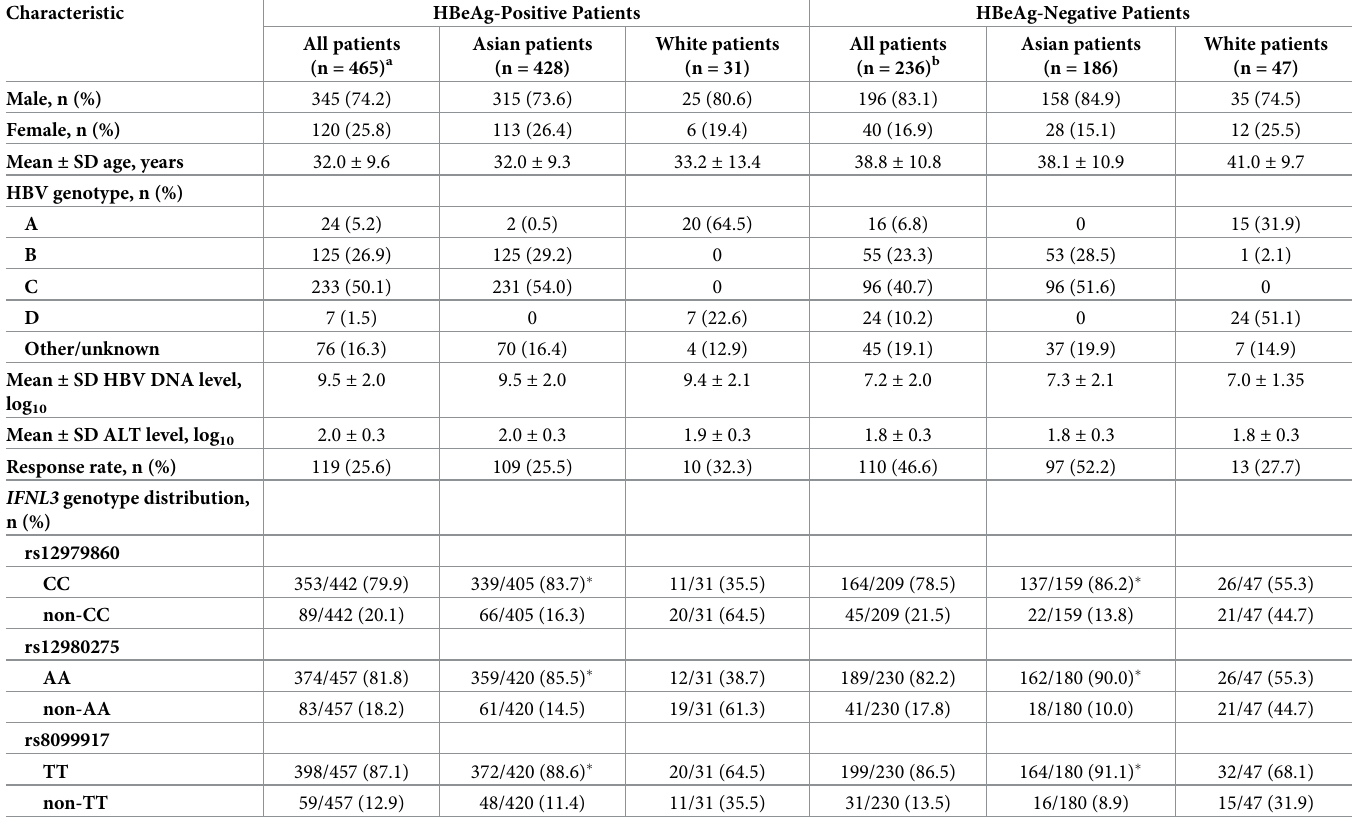
Table 1. Demographic and clinical characteristics of patients Included in the